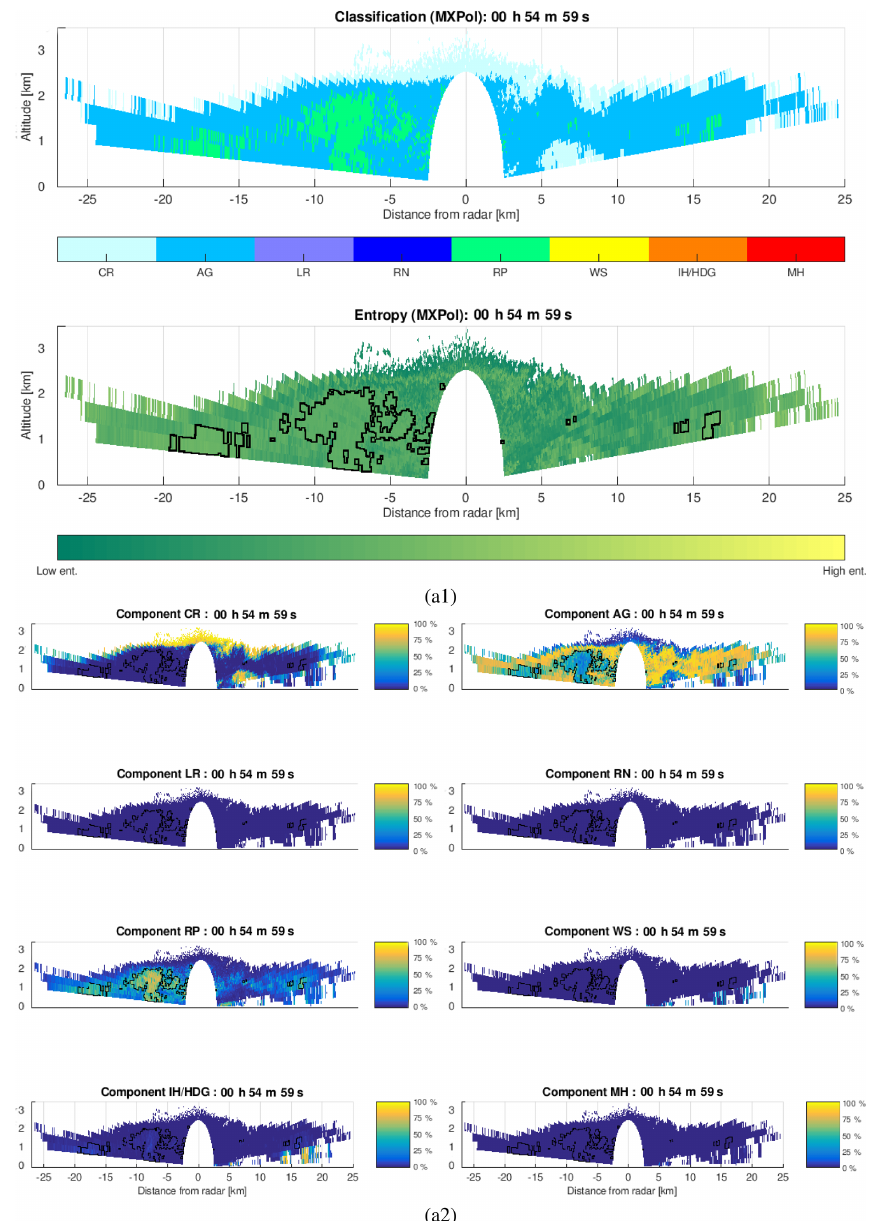
Figure 9. Bin-based de-mixing applied to an example MXPol dataset acquired during the APRES3 campaign at the Dumont-d’Urville base, Antarctica, on 28 January 2016: (a) classification followed by the entropy estimate, (b) proportion of eight hydrometeor classes in each of the radar sampling